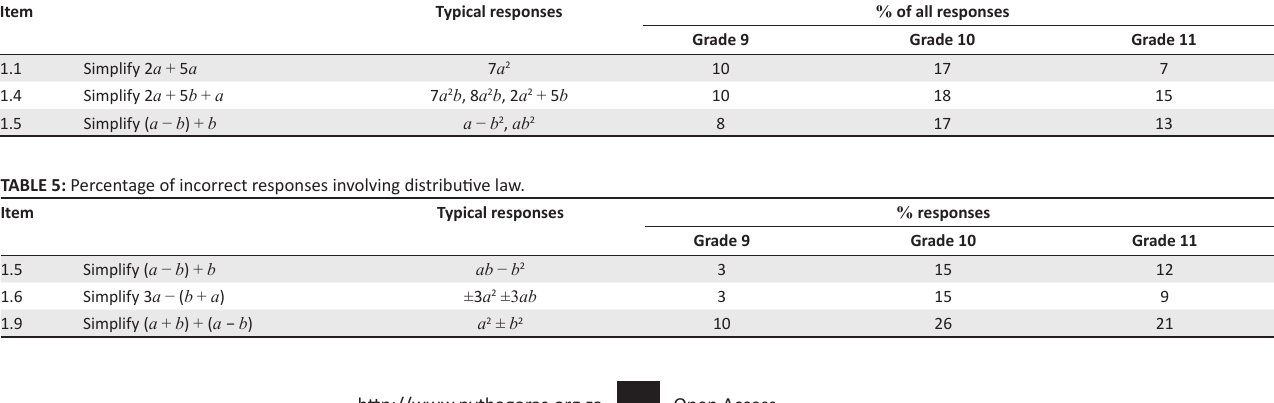
TABLE 4: Percentage of incorrect responses involving exponential laws. Item Typical